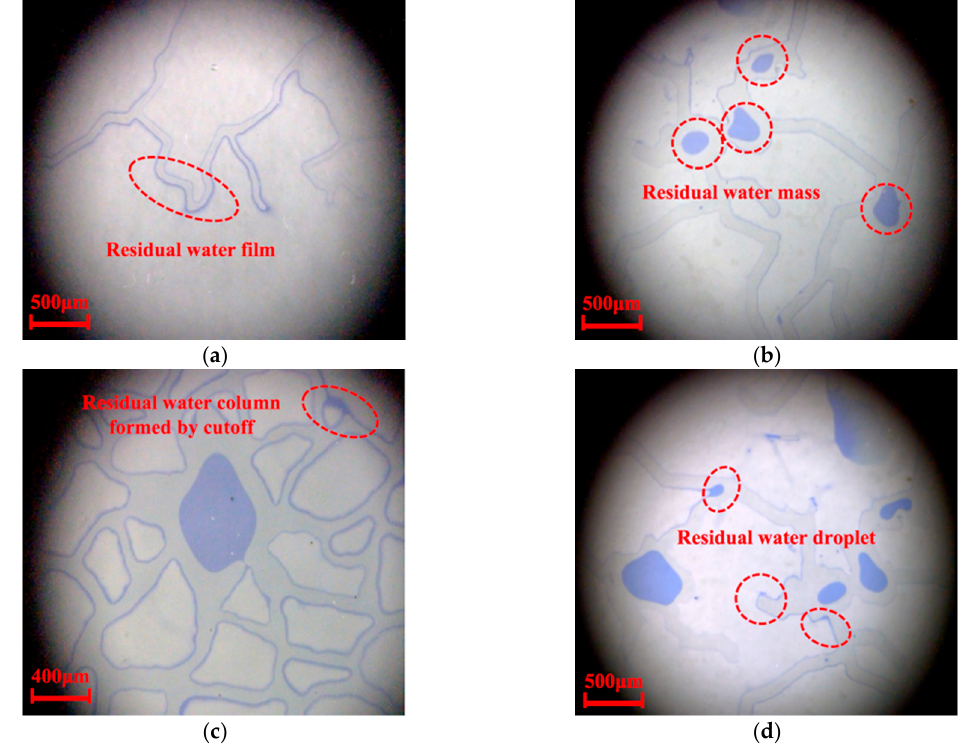
Figure 14. Occurrence states of residual water after gas-drive-water visual experiments: ( a ) Residual water film on the fracture walls; ( b ) Residual water mass at the bottom of the cavity; ( c ) Residual water column formed by cutoff; ( d ) Residual water droplet at the dead end and blind corner.